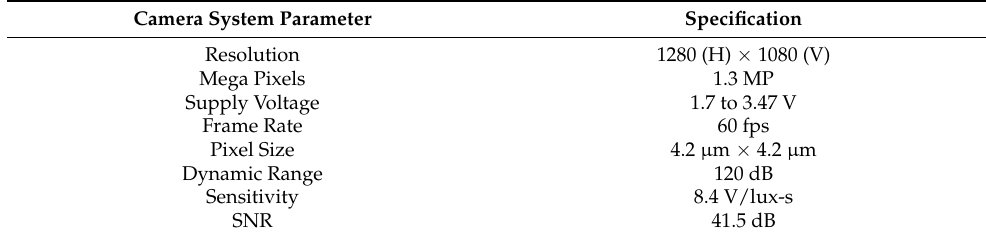
Table 12. Specifications of OmniVision OV10640 camera